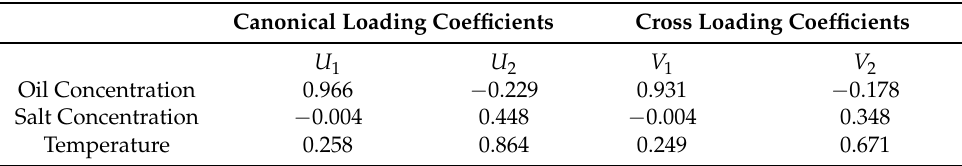
Table 5. Loading coefficients of input set.